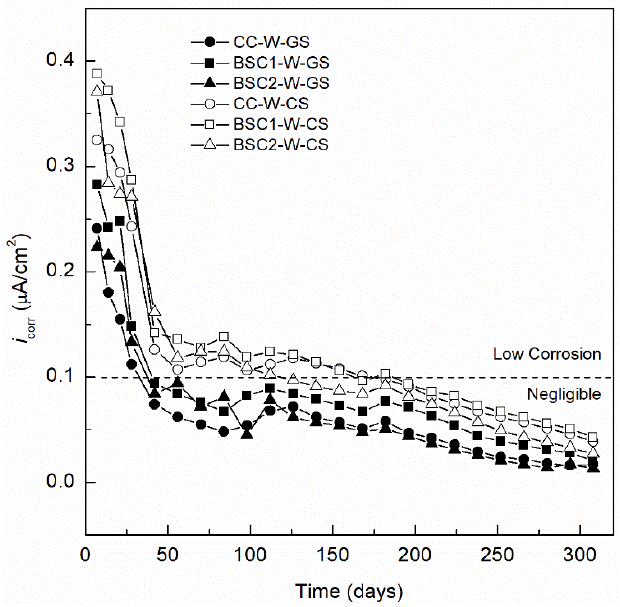
Figure 6. i corr monitoring of GS and CS reinforced concrete exposed to control medium